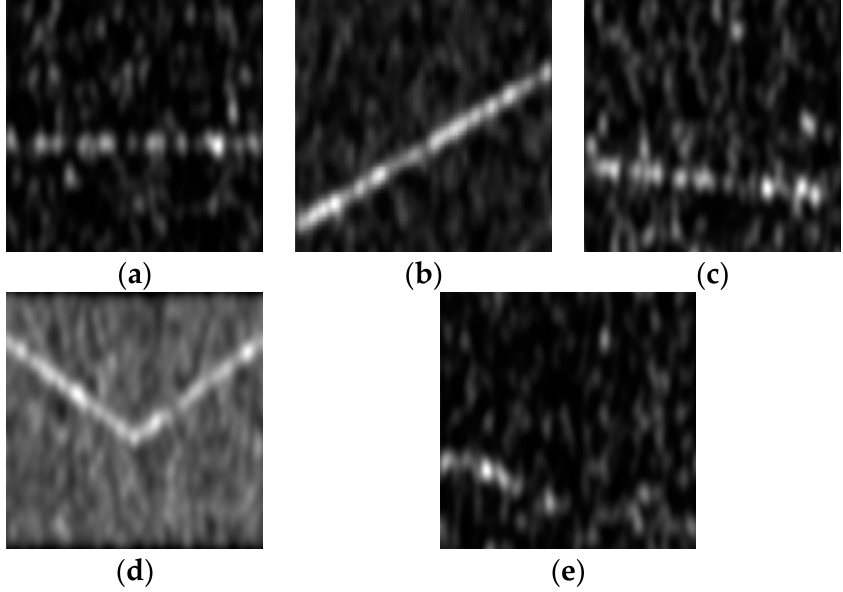
Figure 9. Generated SPWVD of radars’ waveform ( − 10 dB): ( a ) Radar A; ( b ) Radar B; ( c ) Radar C; ( d ) Radar D; ( e ) Radar E.